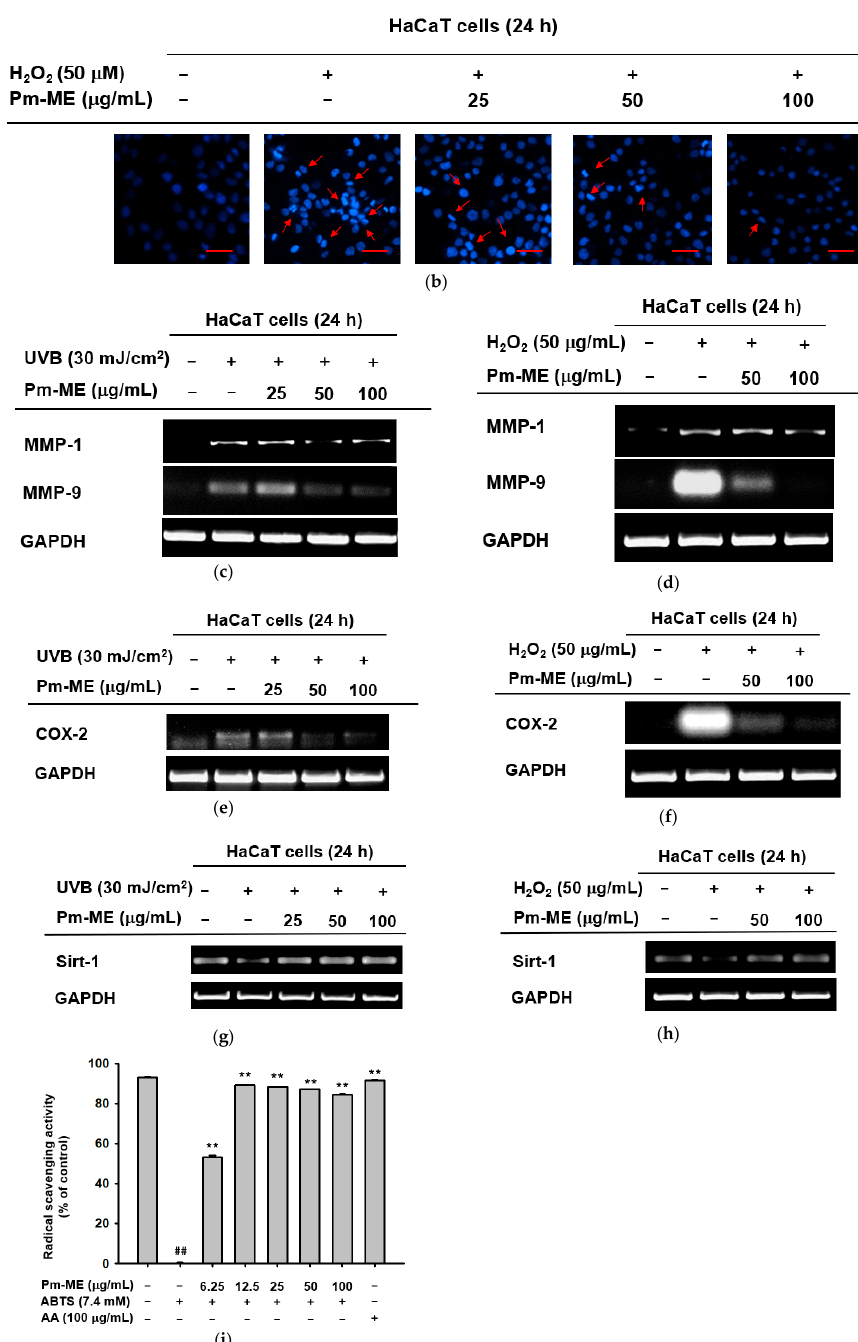
Figure 2. The effect of Pm-ME on UVB- and H 2 O 2 -induced cellular damage, and molecular responses in HaCaT cells. ( a ) HaCaT cells pre-treated with Pm-ME (0–100 µ g/mL) for 30 min were subjected to UVB irradiation (30 mJ/cm 2 ) and then further incubated for 24 h. Morphological changes, adherence, and numbers of cells were assessed by taking photographs with a digital camera. Scale equivalent to 1 mm ( b ) HaCaT cells pre-treated with Pm-ME (0–100 µ g/mL) for 30 min were treated with H 2 O 2 (50 µ M) for 24 h. The generation of apoptotic bodies was examined by 4 (cid:48) ,6-diamidino-2-phenylindole (DAPI) staining (Sigma–Aldrich) of the nucleus followed by confocal microscopy. Red arrows indicate apoptotic bodies. Scale equivalent to 100 px ( c – h ) Reverse transcription-polymerization chain reaction (RT-PCR) was used to determine the mRNA expression levels of MMP-1 , MMP-9 , COX-2 , and Sirt-1 from UVB- or H 2 O 2 -treated HaCaT cells pre-treated with Pm-ME. ( i ) The radical scavenging effect of Pm-ME was measured by ABTS assay ** p < 0.01 versus an induced group (##). AA: ascorbic